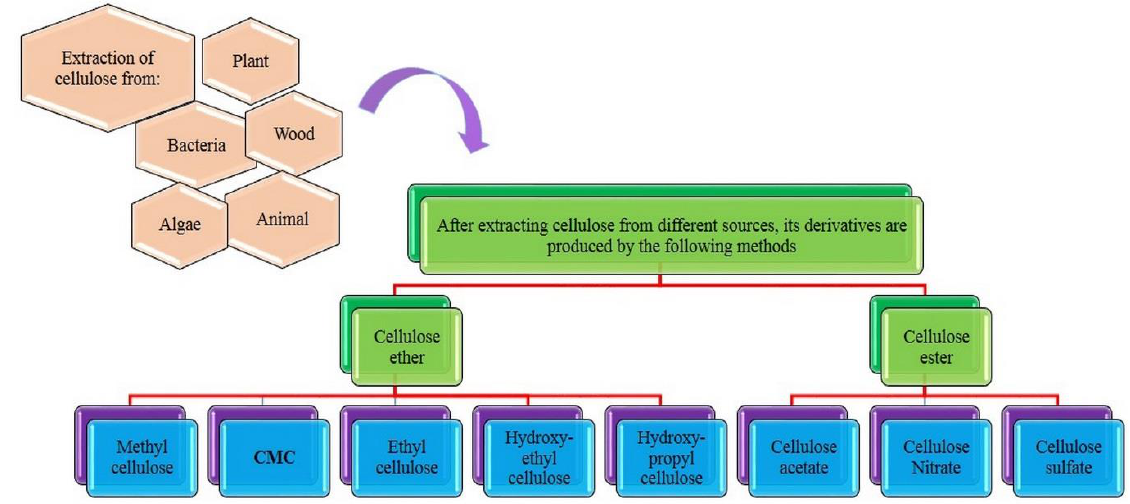
Figure 3. Different sources of cellulose and types of derivatives of this polymer.